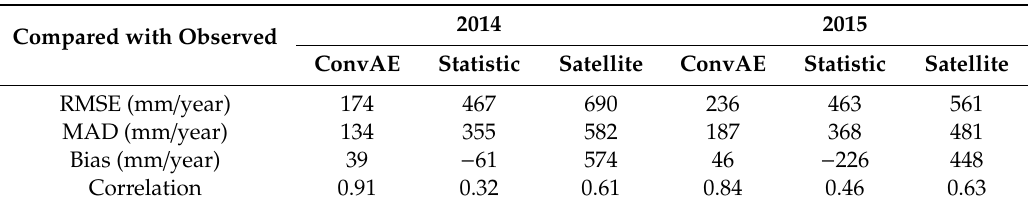
data during the testing